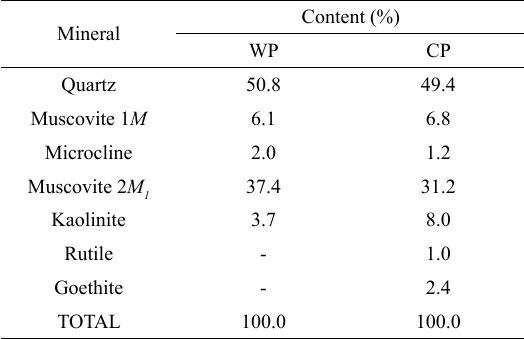
Figure 3. STEM Bright field images of 6 h calcined white phyllite with (a) agglomerates of calcium-rich particles (Energy Dispersive X-ray Spectroscopy results not shown) and (b) a particle with pseudo-hexagonal morphology characteristic of kaolinite. The Metakaolin had (c) tubular particles related either to the mineral halloysite or tubular kaolinite. Table 3. Mineralogical composition of phyllites by the Rietveld Method.